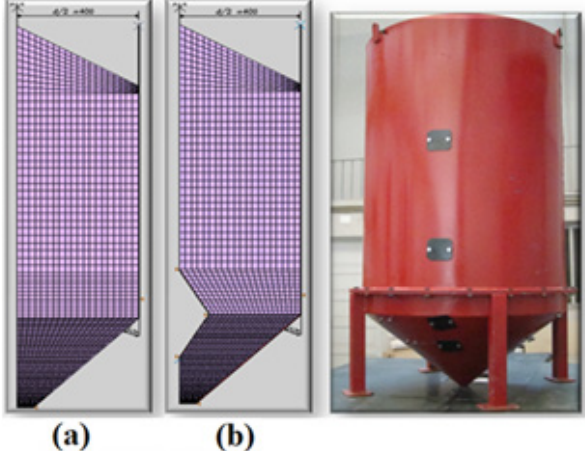
Figure 13: Peripheral conditions applied to the numerical model: (a) without an input element and (b) with an input